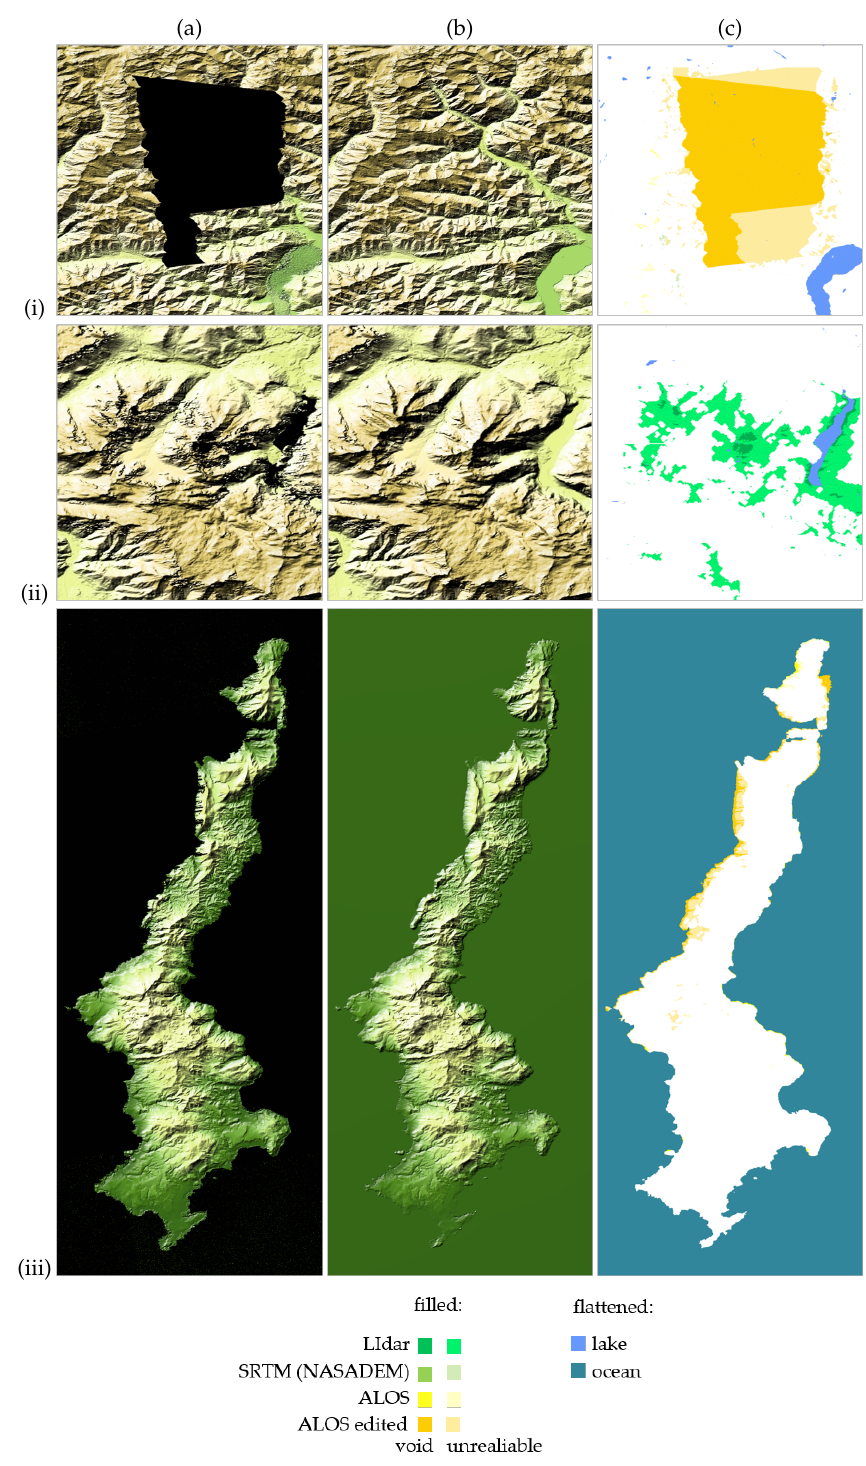
Figure 13. Example of 3 local edited areas: ( i ) the Swiss Alps around lake Maggiore, ( ii ) the German/Austrian Alps around Königssee, ( iii ) Karpathos island, Greece. From left-to-right, each column shows: ( a ) the unedited TanDEM-X DEMs, ( b ) the corresponding edited TanDEM-X DEMs, ( c ) the editing